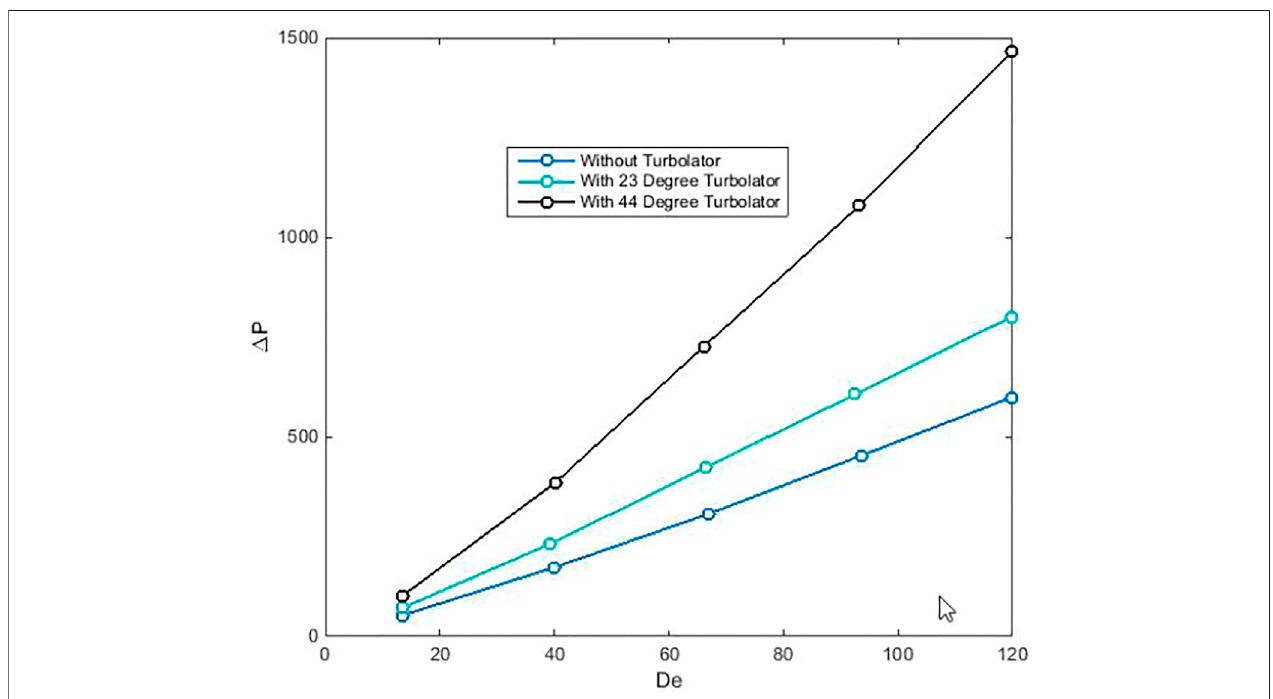
FIGURE 11 | The comparison between pressure loss value of the heat exchanger without Turbolator and heat exchangers with optimized and speci fi c turn of Turbolator.